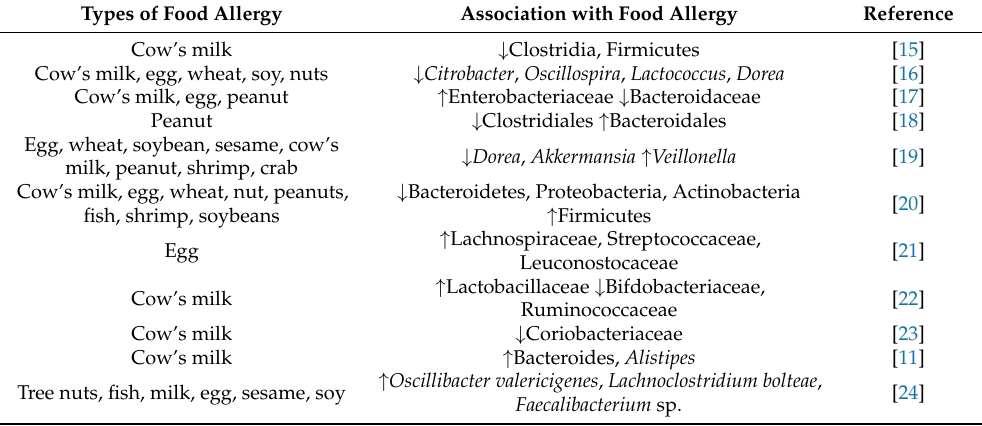
Table 1. Relevant alterations in the composition of GI tract microbiota in the presence of